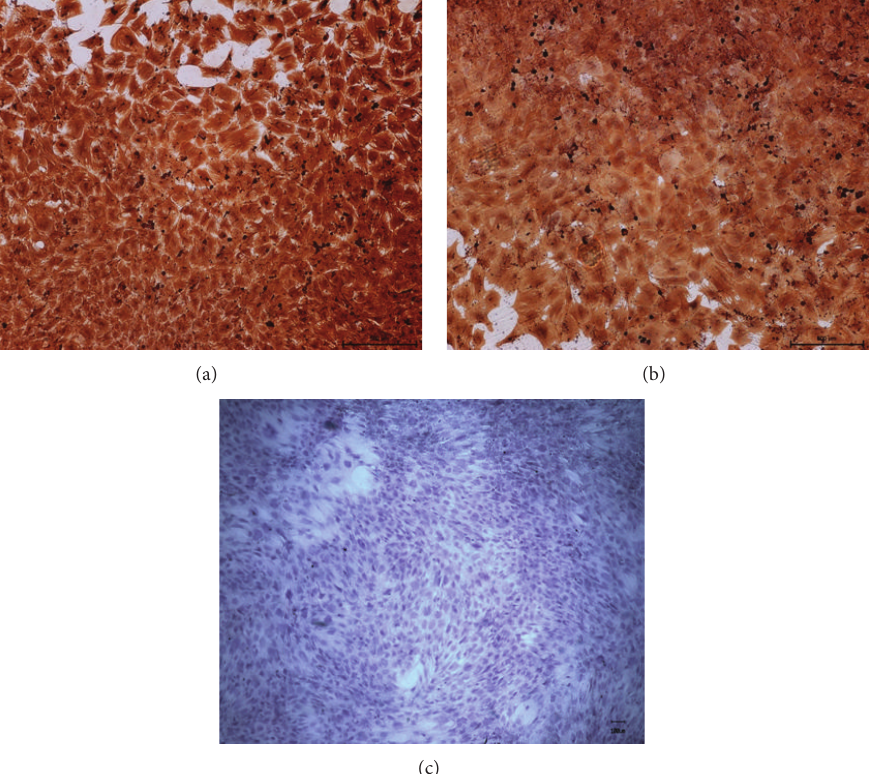
Figure 2: Immunohistochemical staining of MSCs. CD 44 positive marker (a), CD 29 positive marker (b), and CD 45 negative marker